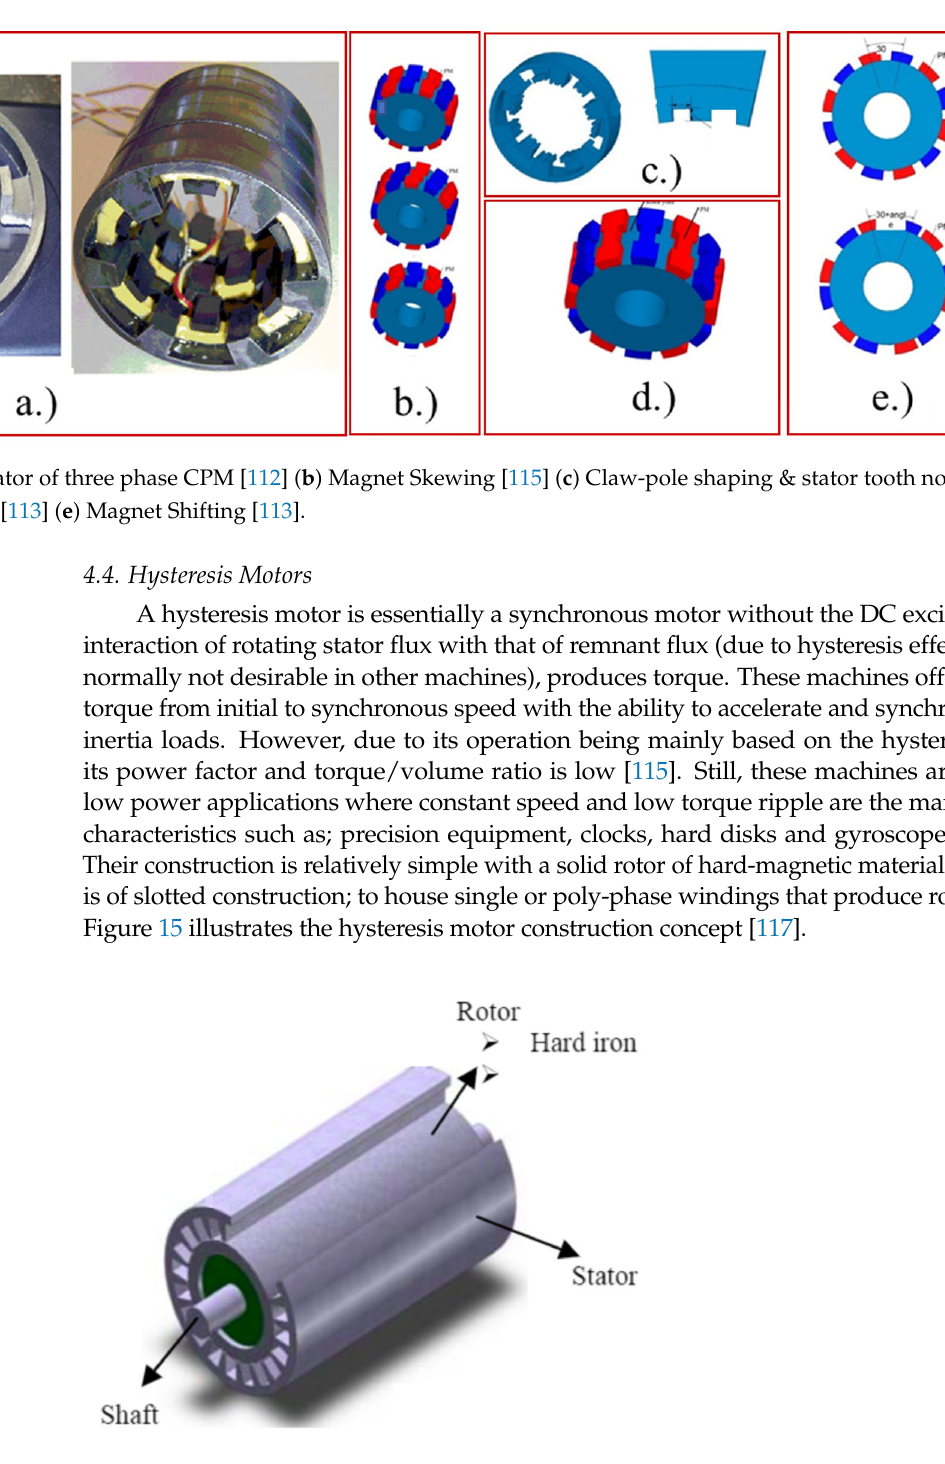
Figure 15. Illustration of hysteresis motor construction